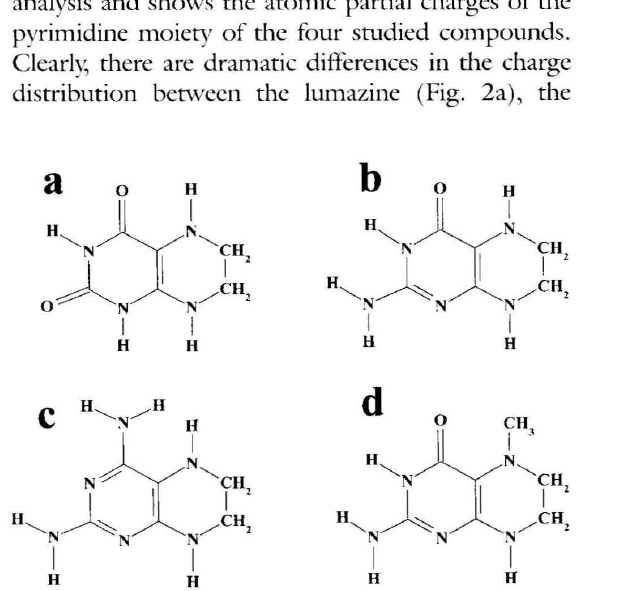
figure 1. Chemical structures of the compounds studied. a) tetrahydrolwnazine, b) tetrahydropterin, c) 4-amino tetrahydropterin, d) N 5-methyl tetrahydropterin.